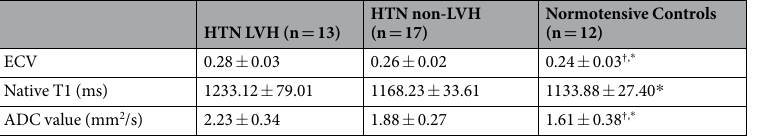
Table 2. Subgroups analysis. Values are mean ± SD. * p < 0.05 vs. HTN LVH. † < 0.05 vs. HTN non-LVH; ECV = extracellular volume; HTN = hypertensive; LVH = left ventricular hypertrophy. Extracellular volume, Native T1, and Native T1 Values in HTN LVH, HTN non-LVH and Normotensive